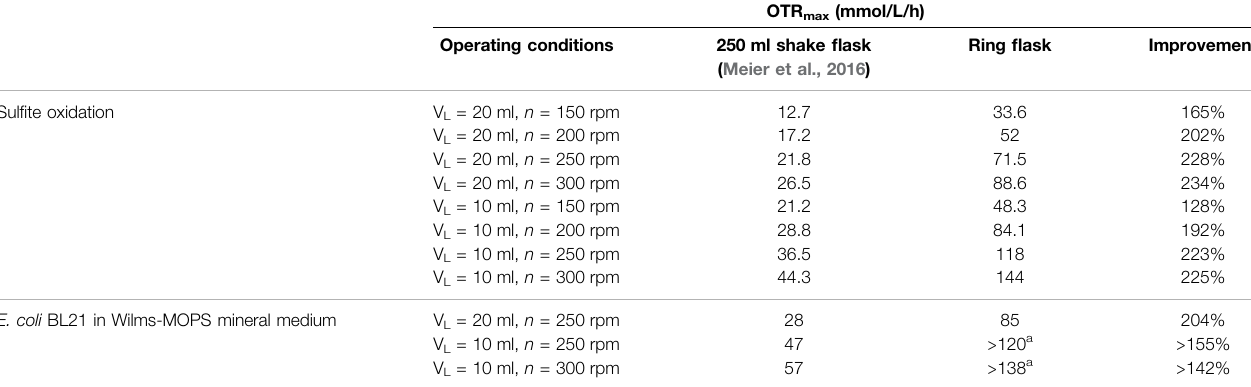
TABLE 1| Maximum oxygentransfercapacities oftheperforatedring fl askwithinnervesseldiameterd i =80 mm, innerring diameterd ring,i =70.6 mm, wallthicknessd wall = 2.2 mm, and 2 perforations of 3 mm × 3 mm size in comparison to a 250 ml shake fl ask.